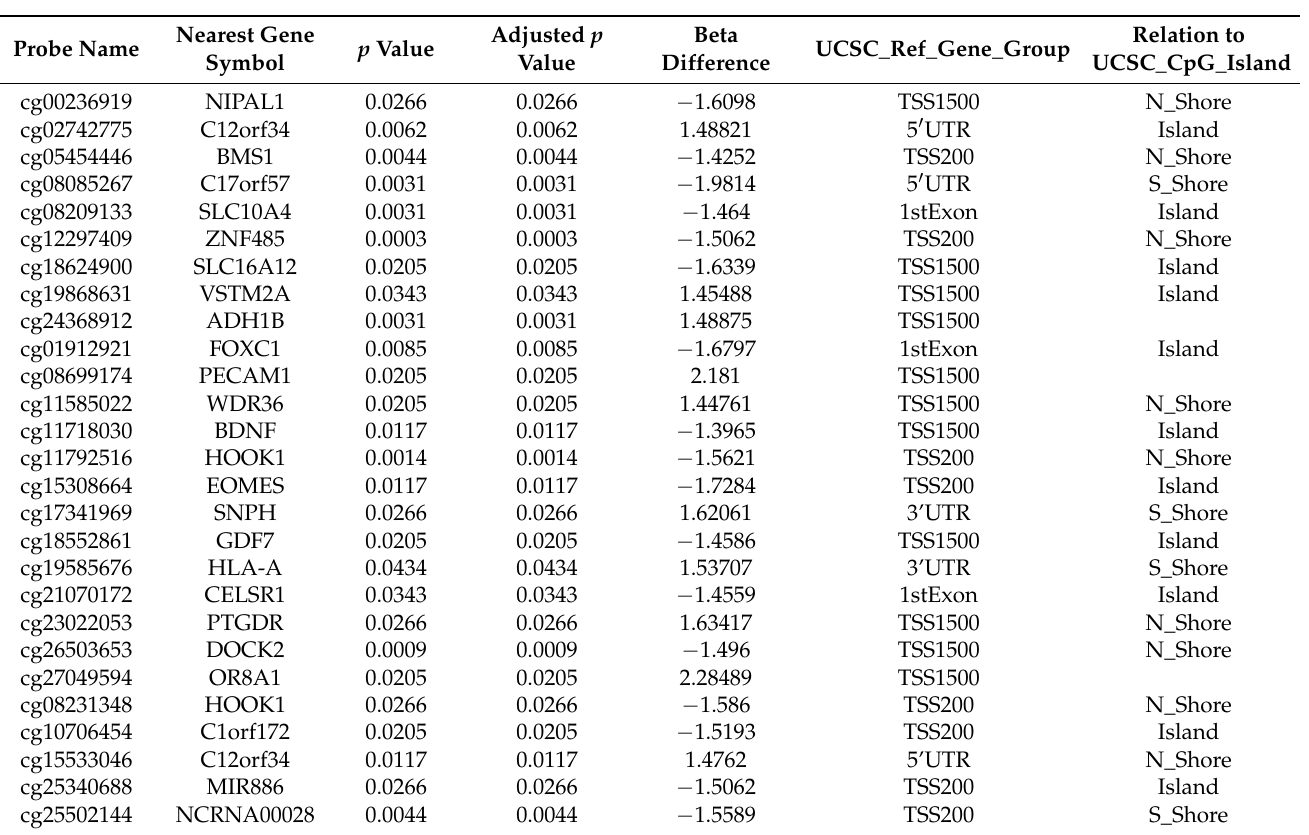
Table 1. The list of 27 differentially methylated genes located up to 1500 bp upstream of transcription start site (TSS), 5 (cid:48) UTR, 1st Exon, 3 (cid:48) UTR to their closest